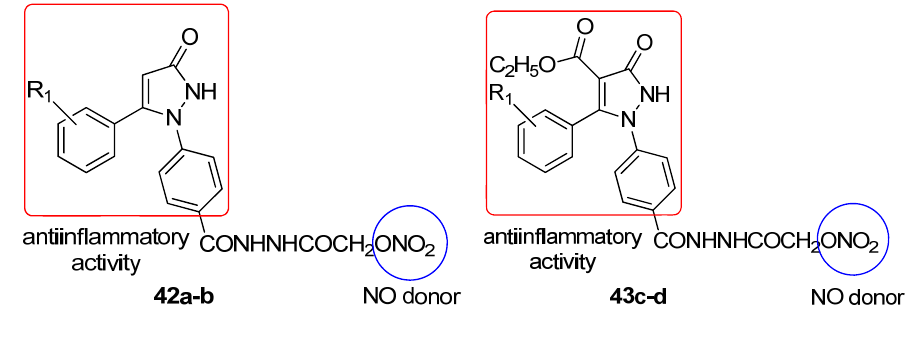
Figure 26. Diarylpyrazol anti-inflammatory derivatives ( 42a R = -4-NO R = -2-OCH ; 43d R = 3